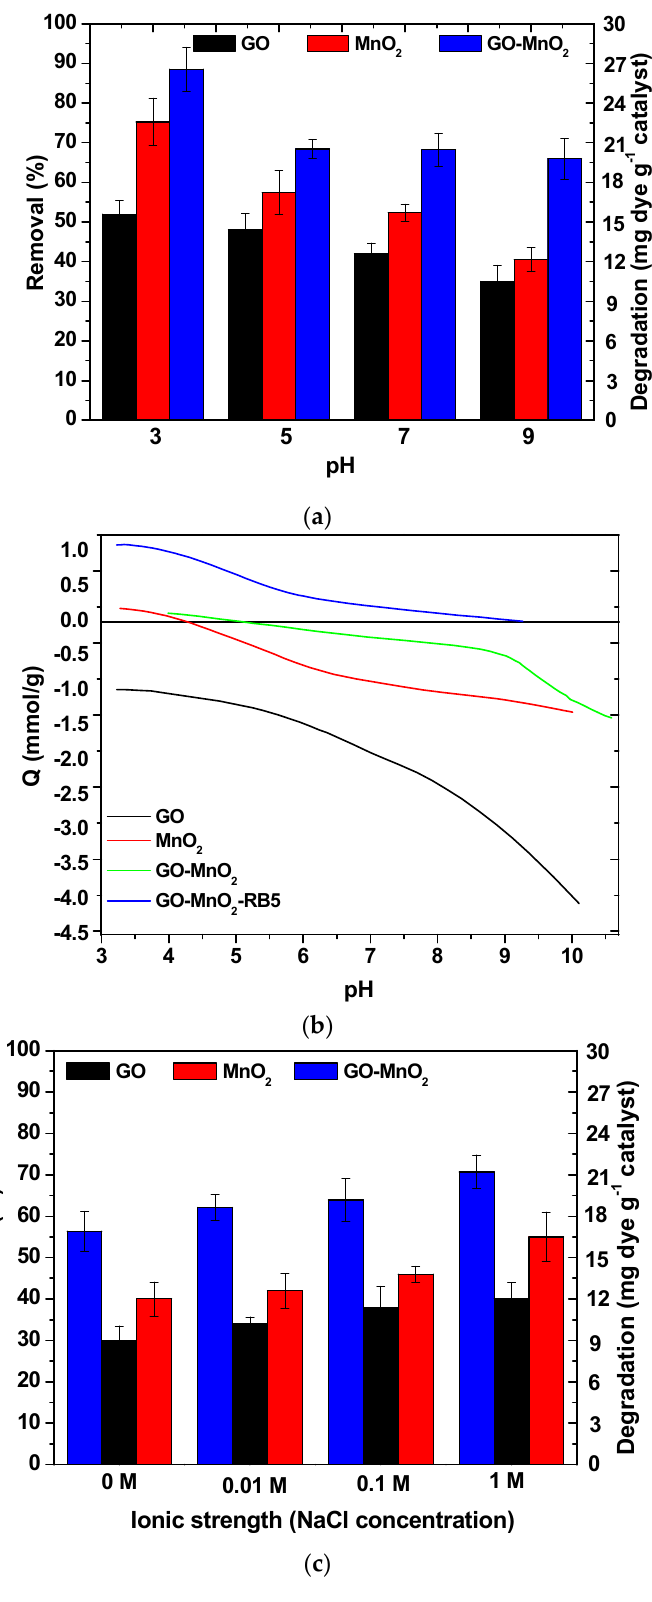
Figure 5. ( a ) Effect of initial pH on Reactive Black 5 (RB5) removal onto MnO 2 and GO ‐ MnO 2 nanocomposite (V = 20 mL; C 0 = 60 mg L − 1 ); ( b ) proton uptake curves for MnO 2 and GO ‐ MnO 2 nanocomposite; ( c ) effect of ionic strength on RB5 adsorption/degradation onto GO ‐ MnO 2 (V = 20 mL; C 0 = 60 mg L − 1 ).